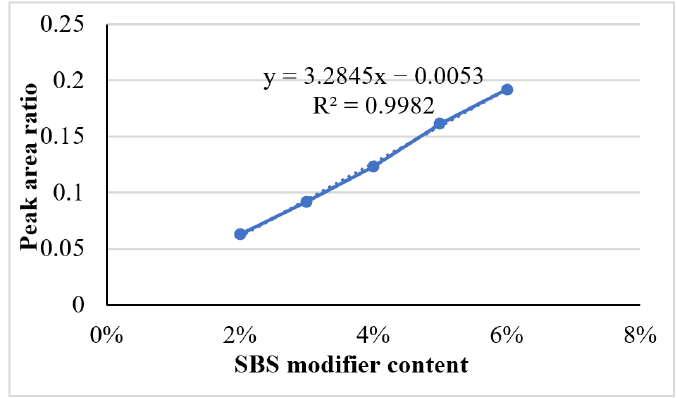
Figure 10. Standard curve of YH-791.